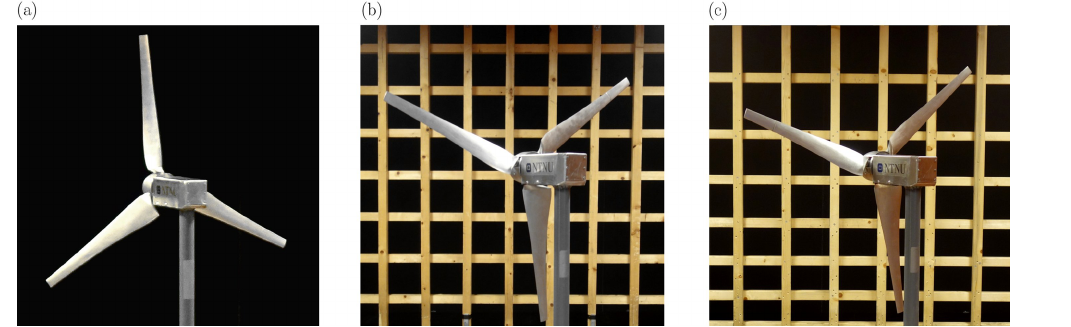
Figure 1. Yawed model wind turbine exposed to different inflow conditions: (a) TI A = 0.23%, uniform shear (b) TI B = 10.0%, uniform shear; and (c) TI C = 10.0%, non-uniform